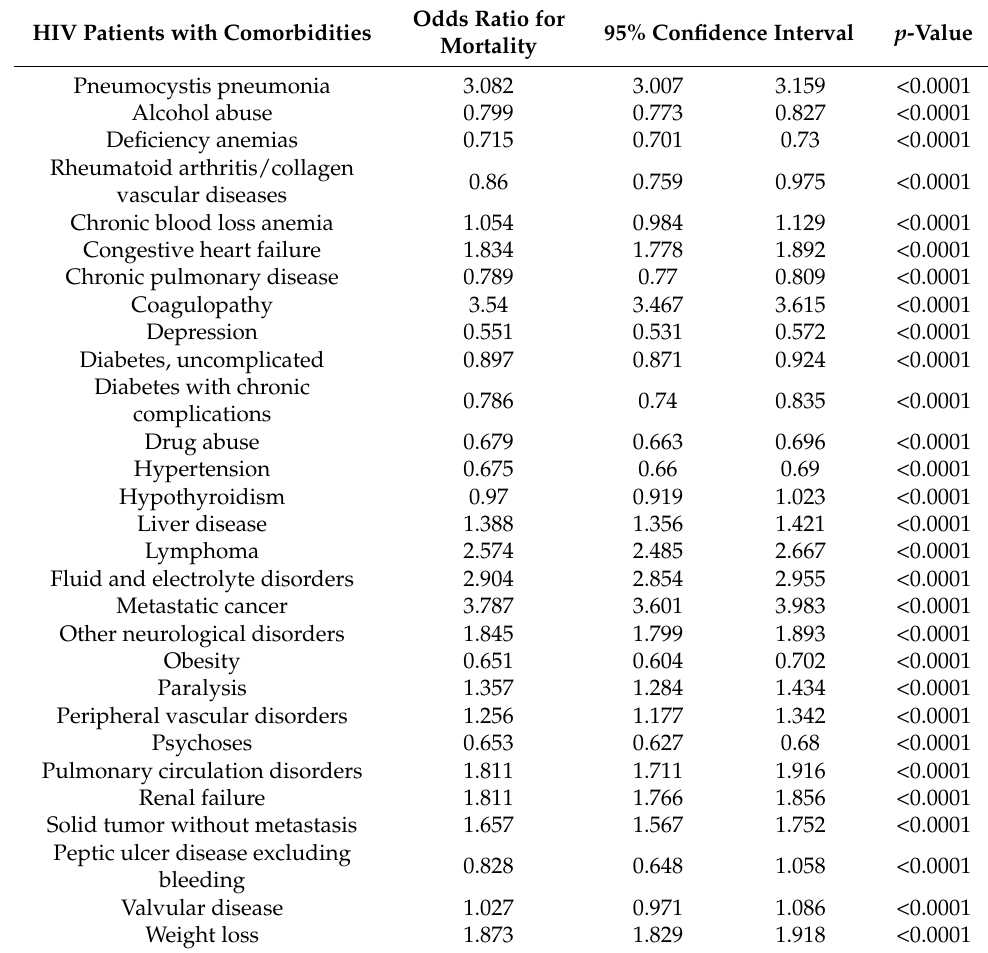
Table 3. Multivariate logistic regression analysis showing the adjusted odds ratios predicting the in-hospital mortality for HIV hospitalizations.